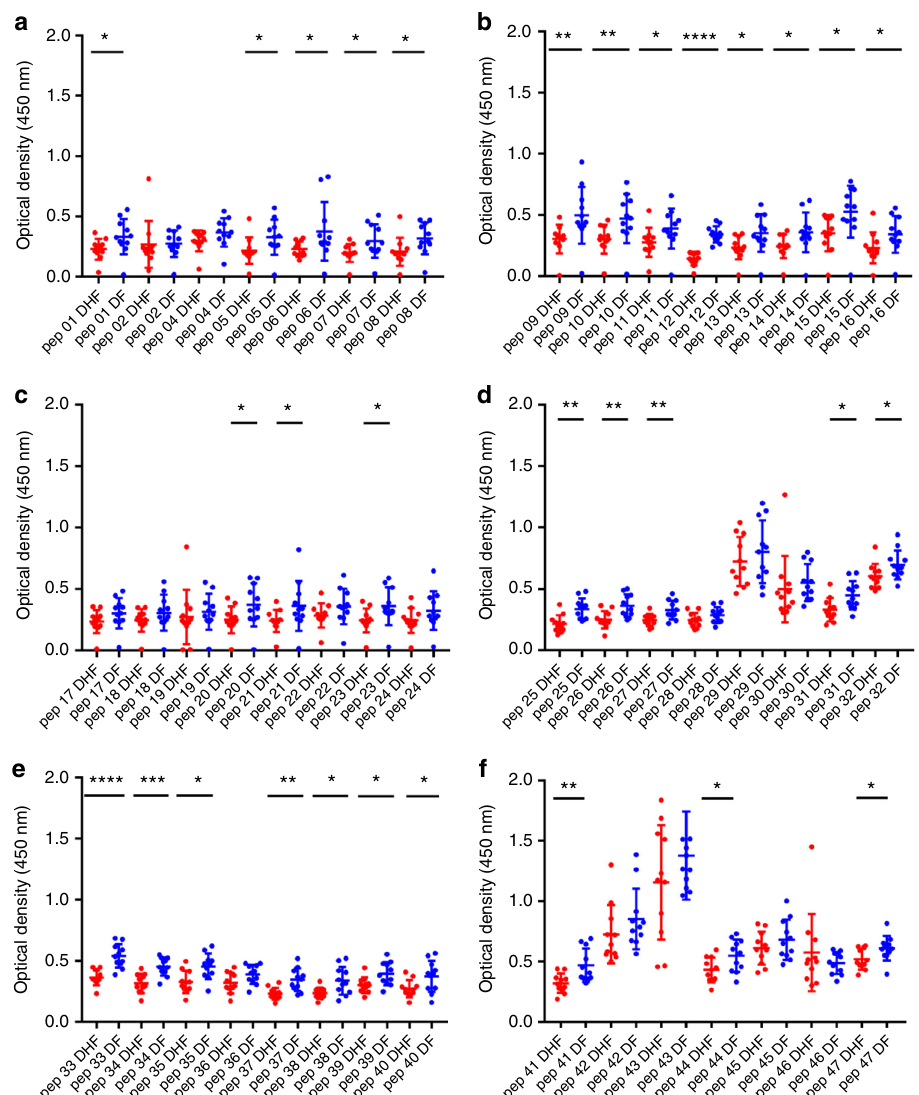
Fig. 4 DENV2 NS1 antibody responses to NS1 peptides in the febrile phase. a – f DENV2 NS1-speci fi c IgG antibody responses to 47 DENV2 NS1 overlapping peptides were measured by ELISA in patients with DF ( n = 10) and DHF ( n = 10) on day 3 of illness. Differences in mean values between antibody responses to overlapping peptides in patients with DF and DHF were compared using the Mann – Whitney U test (two tailed). Error bars indicate the means and standard deviation (SD). * P < 0.05, ** P < 0.01, *** P < 0.001, **** P <